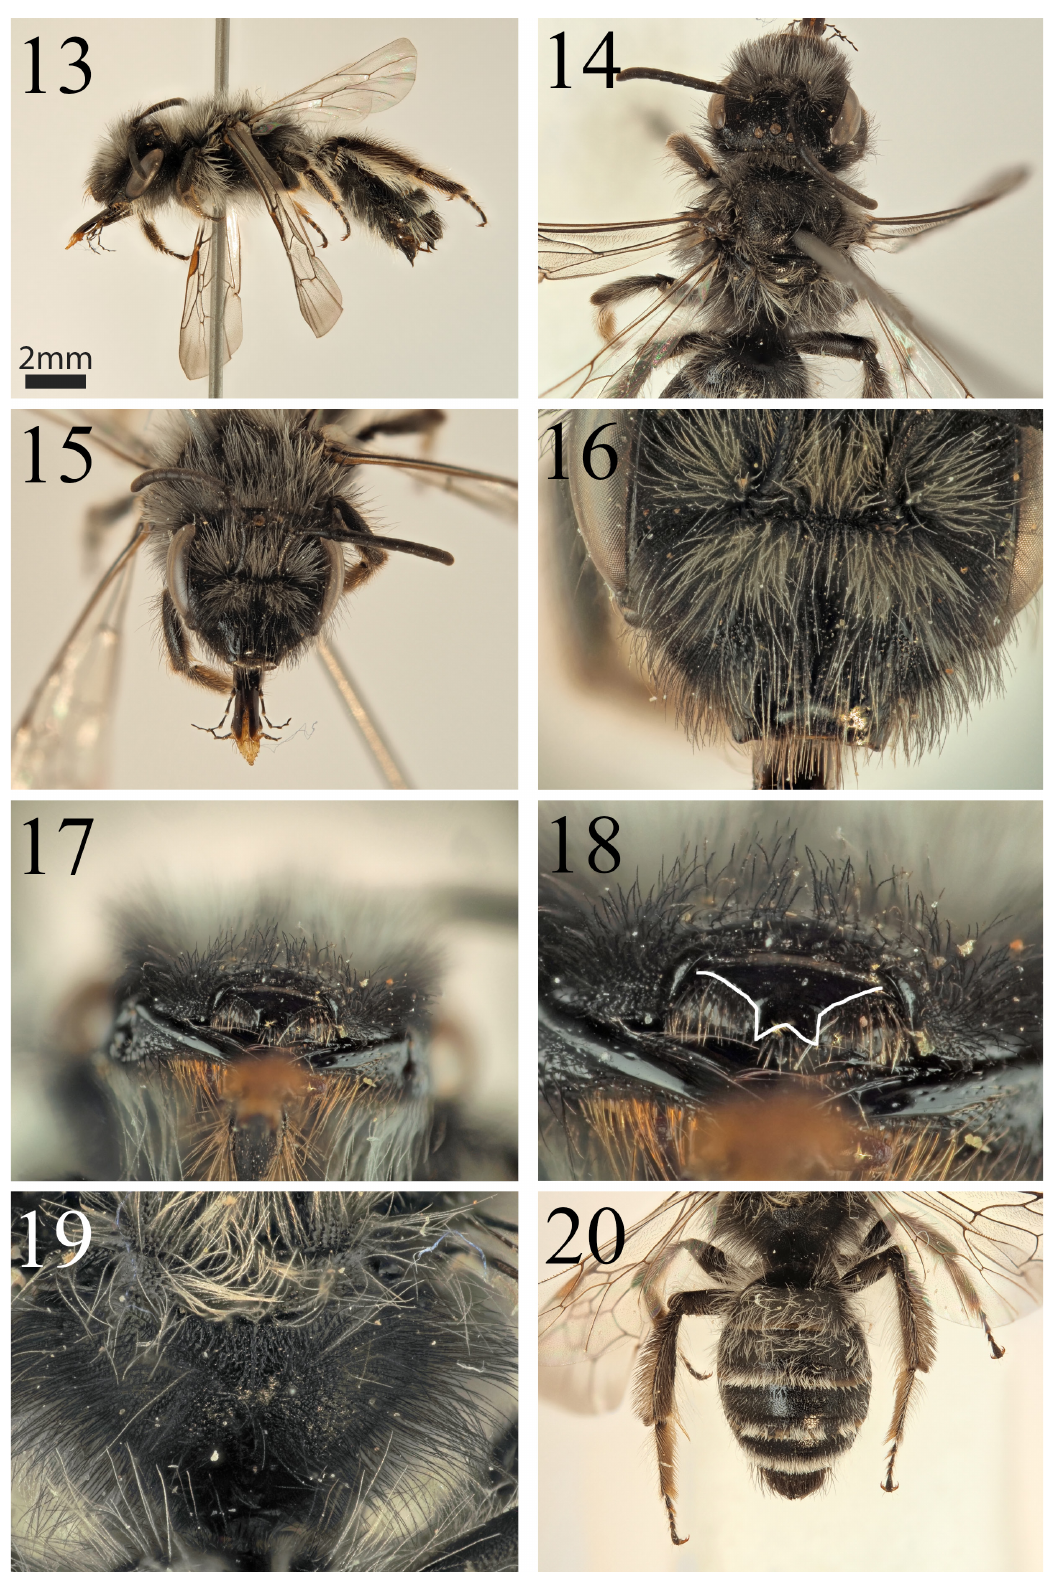
Figs 13–20. Andrena boustaniae Wood sp. nov., ♀ (OÖLM). 13 . Profile. 14 . Dorsum. 15 . Face. 16 . Face, detail. 17 . Process of labrum. 18 . Process of labrum with shape outlined. 19 . Propodeum. 20